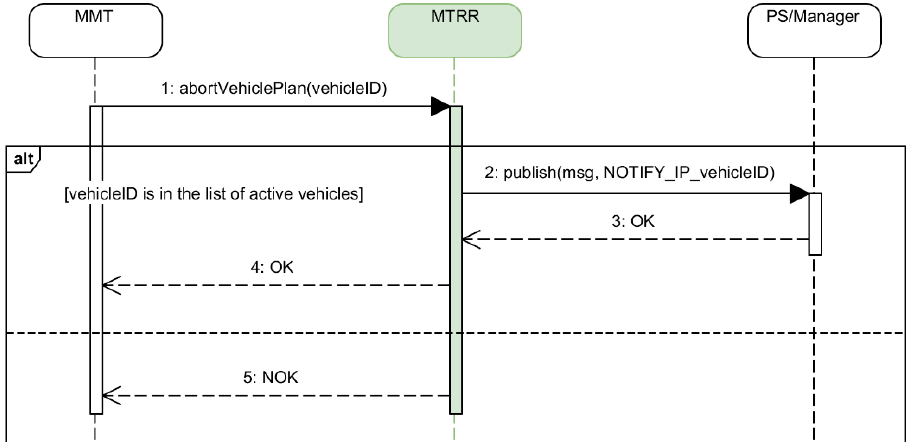
Figure 21. Sequence diagram for aborting a vehicle plan.